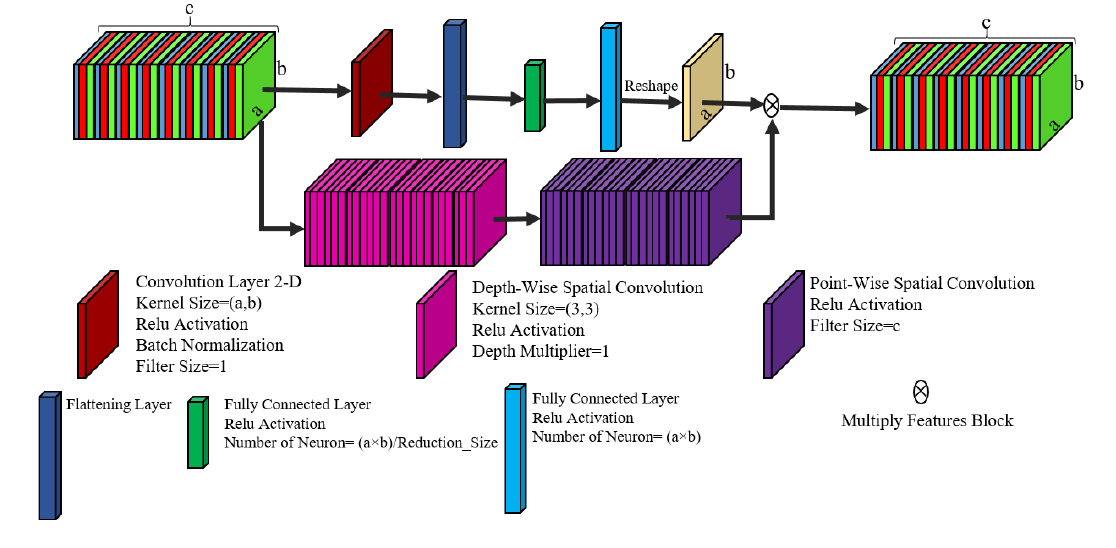
Figure 6. The proposed spatial attention